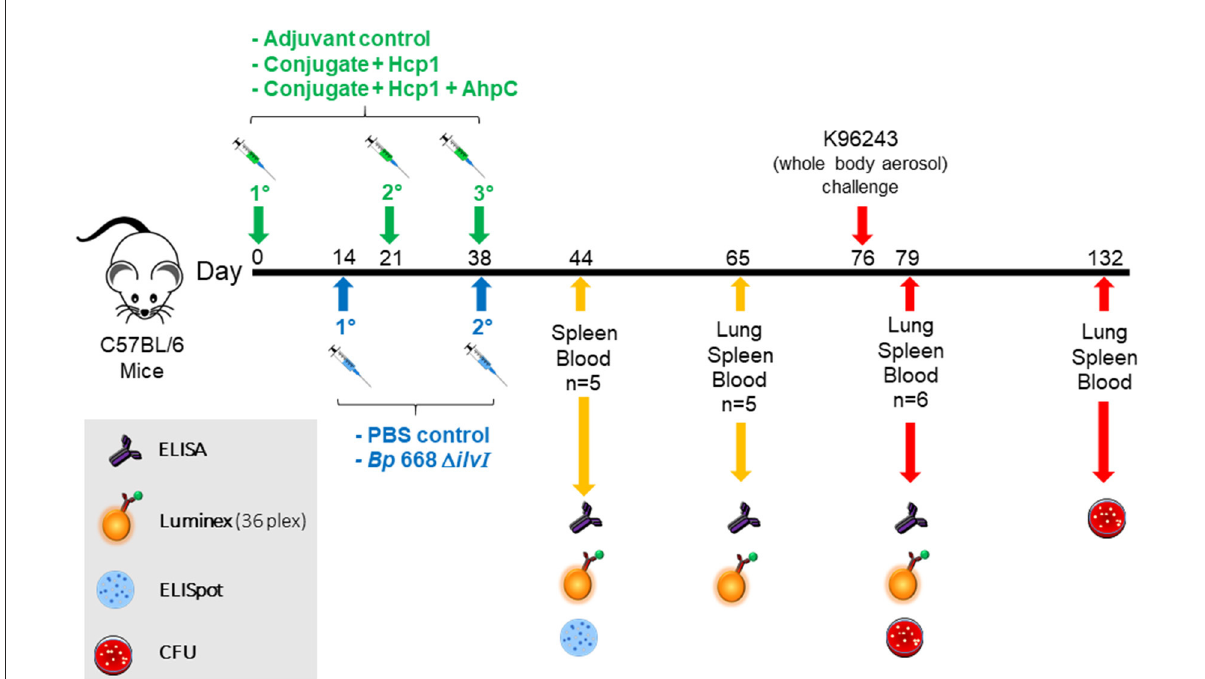
FIGURE1 Overview of the immunization and challenge strategy for direct comparison of Burkholderia vaccine candidates that were challenged with Bp K96243. The numbers with the degree sign ( ◦ ) denote vaccine prime and consecutive boost(s). The experiments that included mice challenged with Bm FMH or Bp MSHR5855 followed a similar